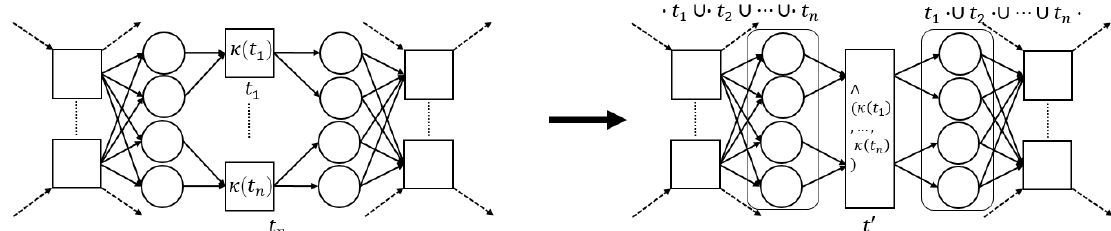
Figure 11. Visualization of the ∧ -pattern reduction. Transitions t 1 ,..., t n have disjunct pre-sets, yet, their pre-sets have the exact same pre-sets. The same holds for the post-sets of transitions t 1 ,.., t n . The replacing transition inherits all pre- and post-sets of t 1 ,.., t n